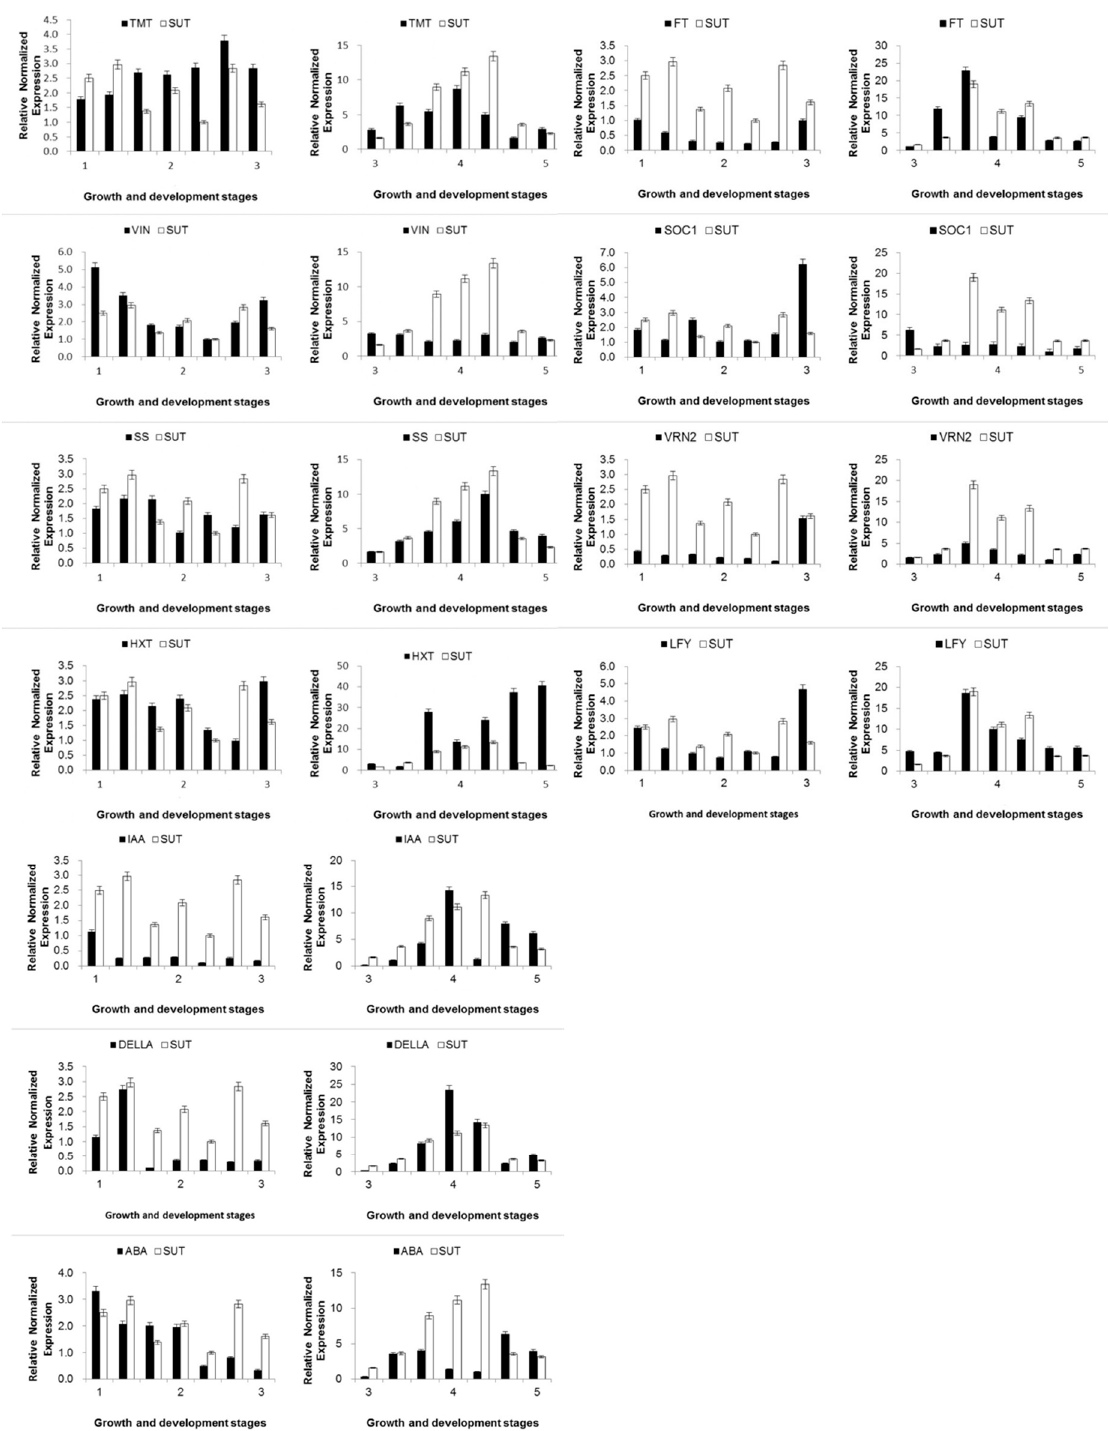
Figure 6. The expression of carbohydrate-related genes, flower differentiation genes and hormone genes in Oriental hybrid lily by qRT-PCR. The relative expression level of the enzyme was calculated to determine the expression level of the gene by 2 − ∆∆ C t . The instrument was a Bio-rad CFX 96 real-time PCR instrument.